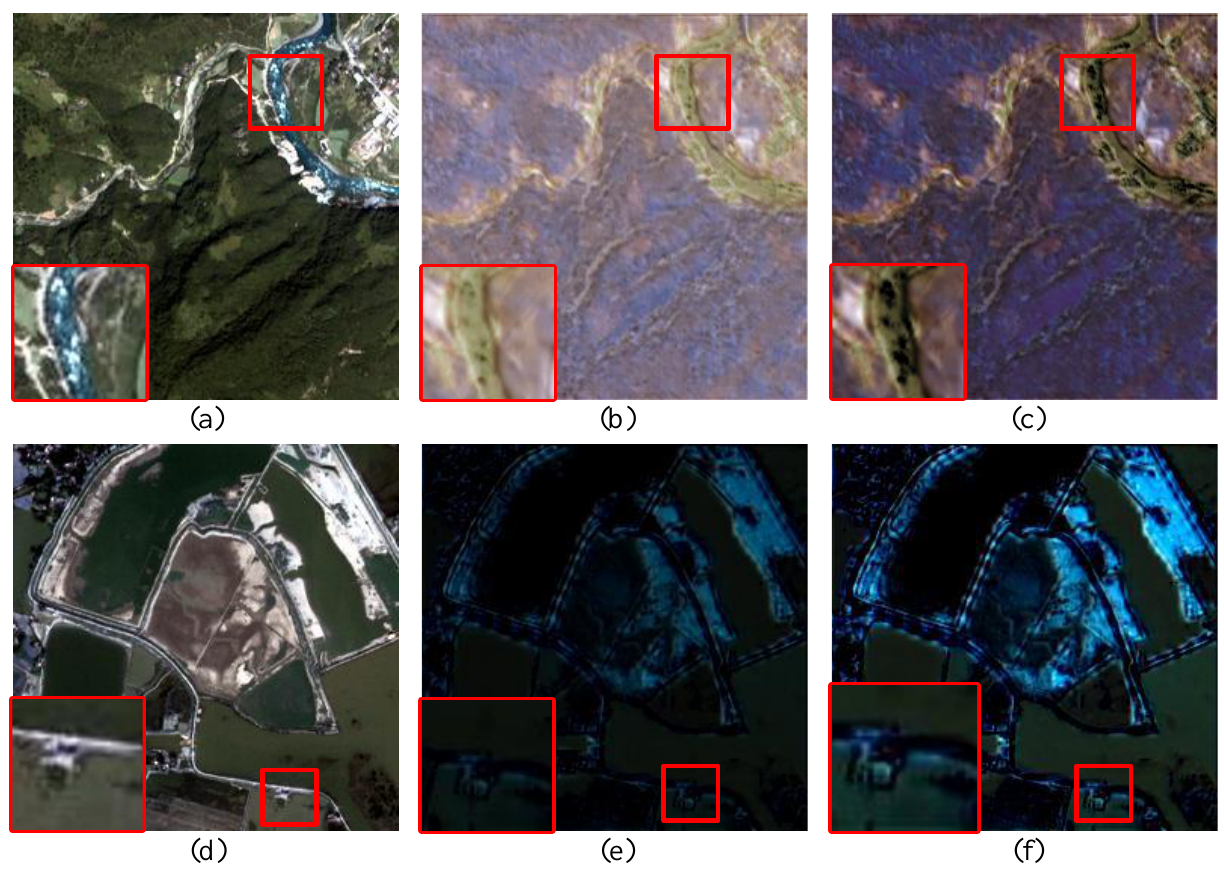
Figure 6. The comparison of feature maps with and without the AG module. ( a ) The ground truth. ( b ) The 53rd feature map in F L . ( c ) The 53rd feature map in F H . ( d ) the ground truth. ( e ) The 23rd 1 1 feature map in F L . ( f ) The 23rd feature map in F H . 1 1